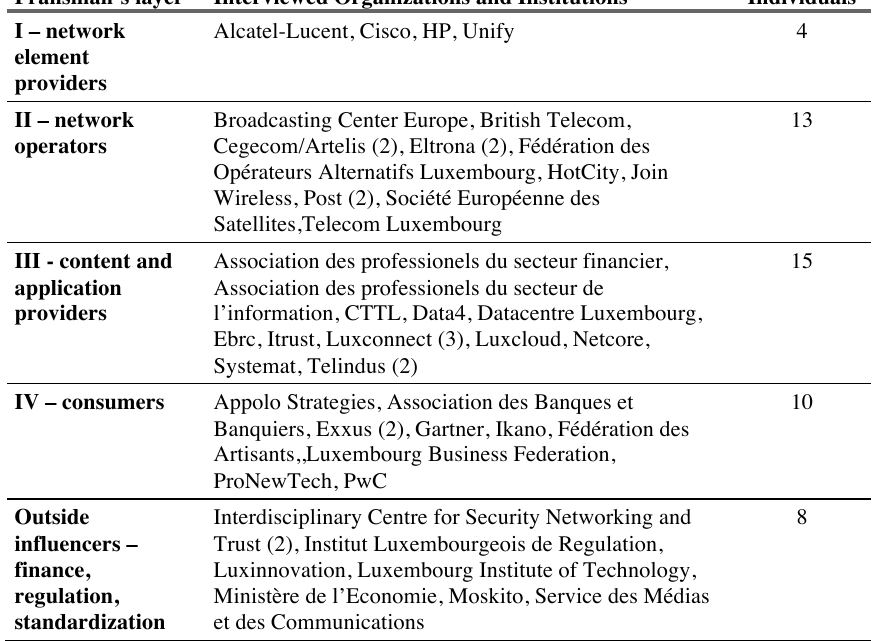
Table 1. Companies and institutions